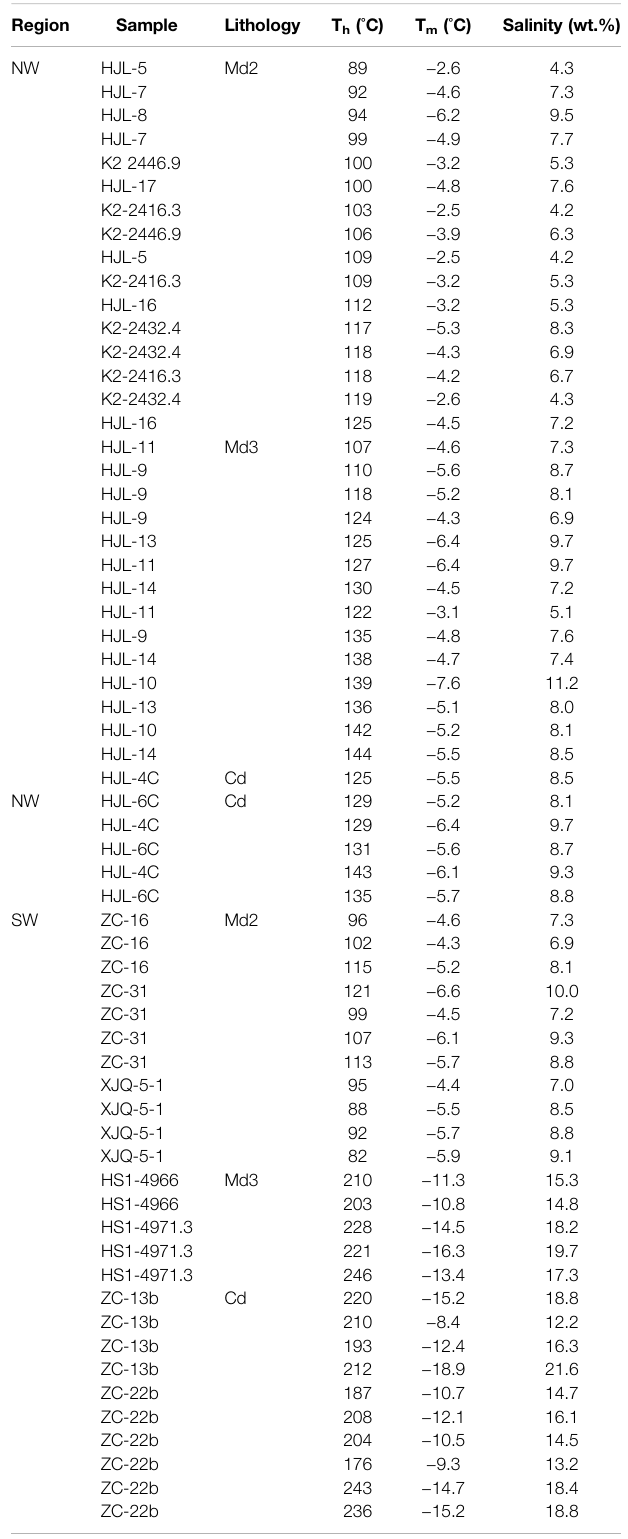
TABLE 4 | Fluid inclusion data of Middle Permian dolomites from the Western Sichuan Basin. (T h — homogenization temperature; T m — ice melting